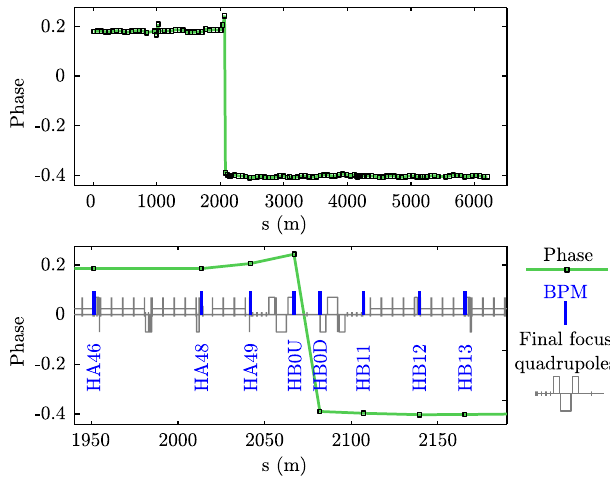
FIG. 10. Vibrating quadrupole location. The initial phase of the betatron oscillations excited by the vibrating quadrupole is shown. The phase was calculated using the pairs of horizontal monitors one after